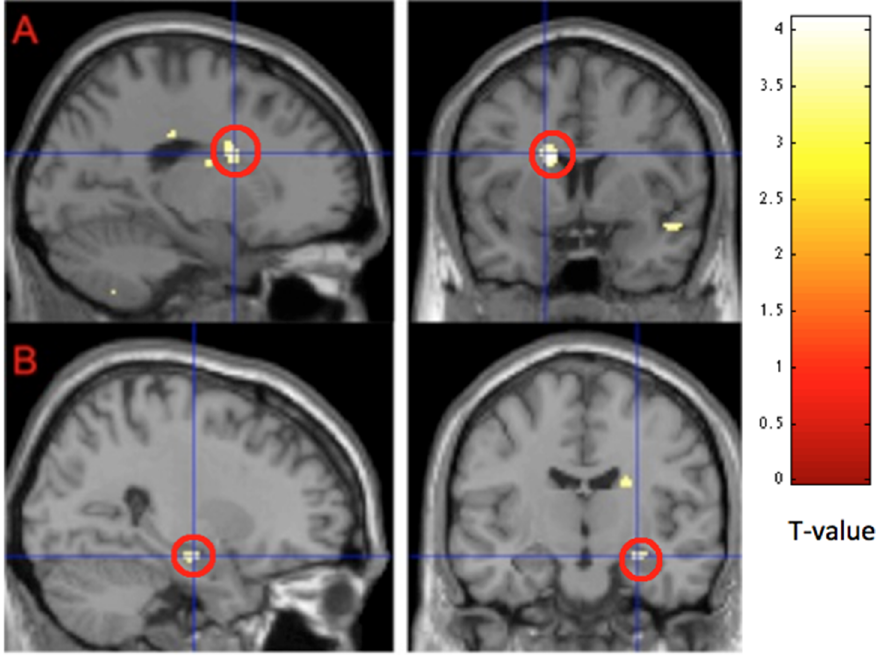
Figure 5. Representation of cerebral activation when contrasting HC . FM for incongruent . congruent stimuli. HC had significantly higher activation than FM patients in A) the caudate nucleus (p , 0.0001, peak voxel) and B) the hippocampus (p , 0.001, peak voxel). Results are reported a threshold setting of p , 0.001, p values are at peak voxel, not corrected for multiple comparisons. doi:10.1371/journal.pone.0108637.g005 PLOS ONE |